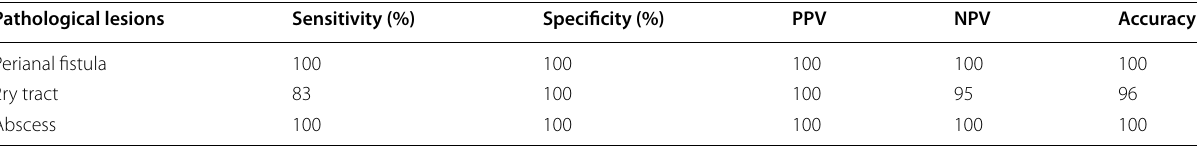
NB values are given as percentage: NPV Negative predictive value; PPV Positive predictive value